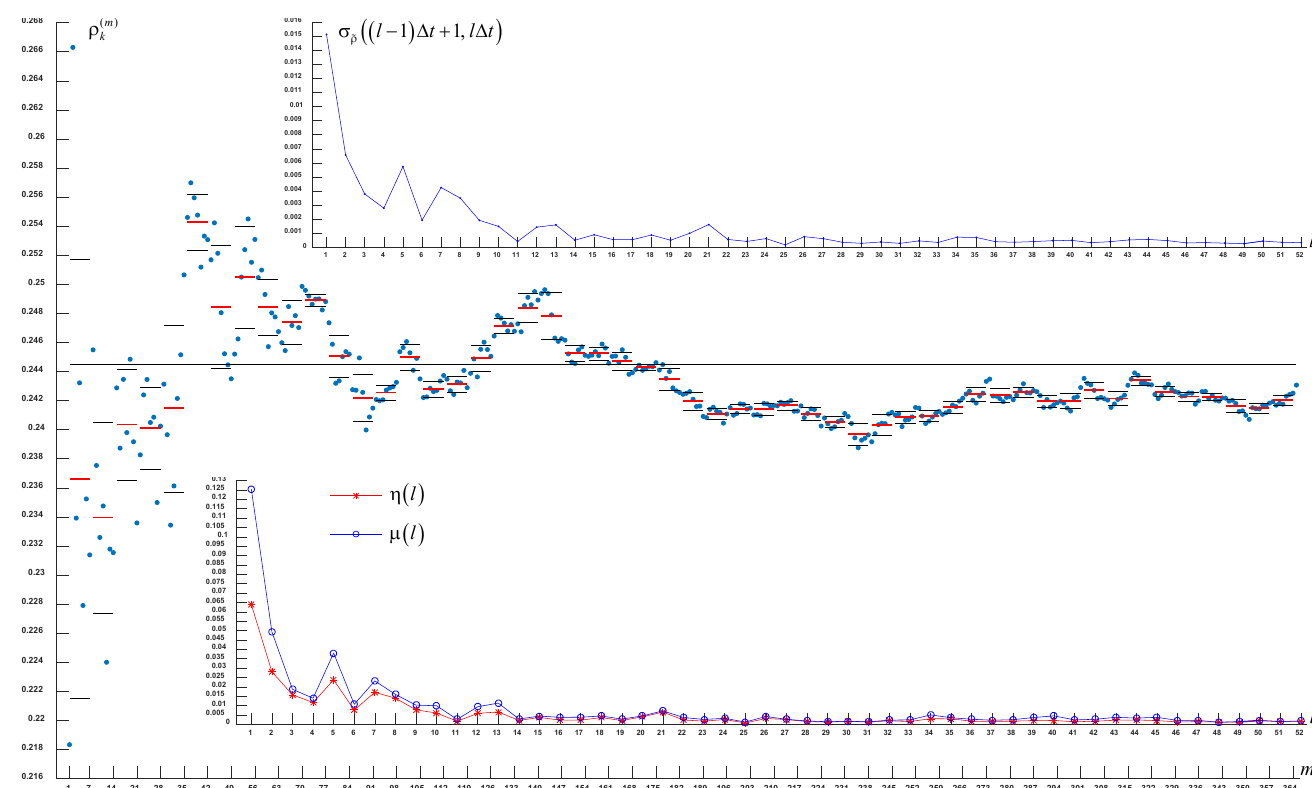
Fig. 2. An example of approximations (11) obtained by the cumulative sum of 365 values (17). The bounds defined by deviations (13) are shown as short lines.